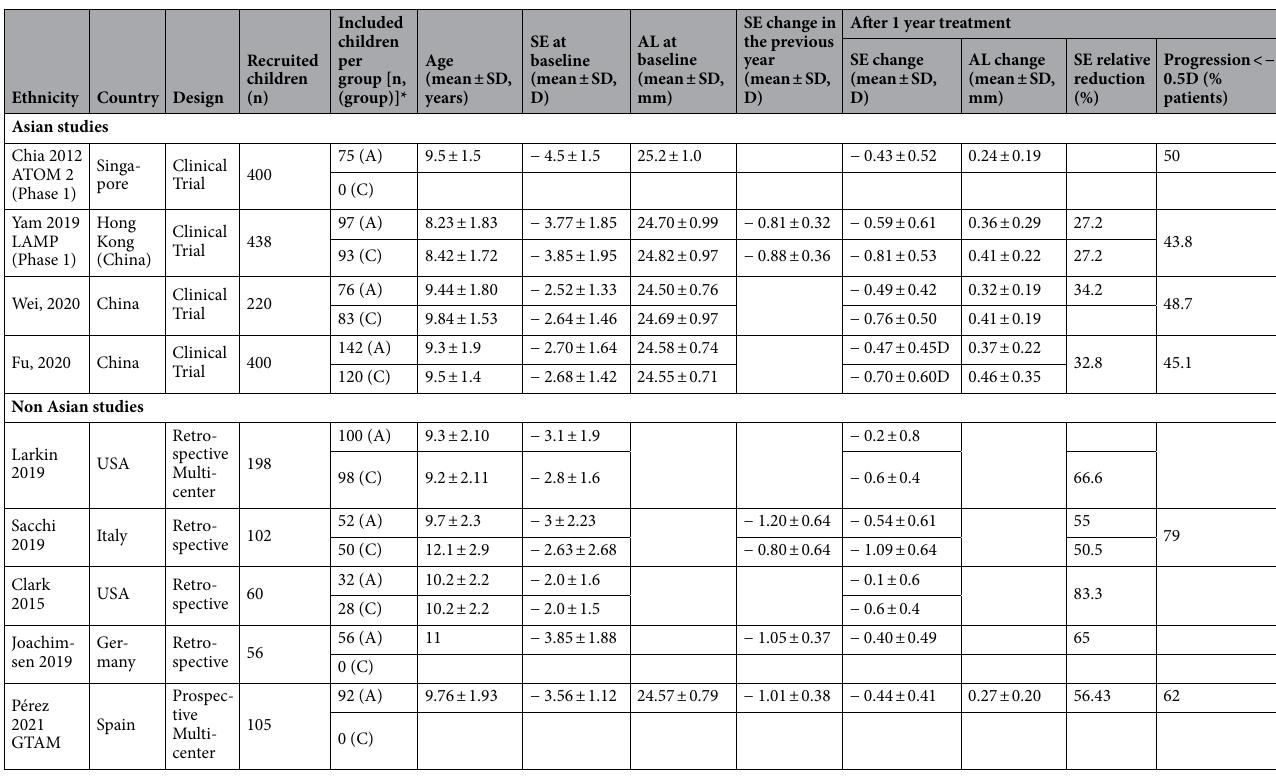
Table 4. One year atropine 0.01% treatment clinical trials and studies results overview. SE Spherical Equivalent, SD standard deviation, D diopter, AL Axial length, *A Atropine group, C Control